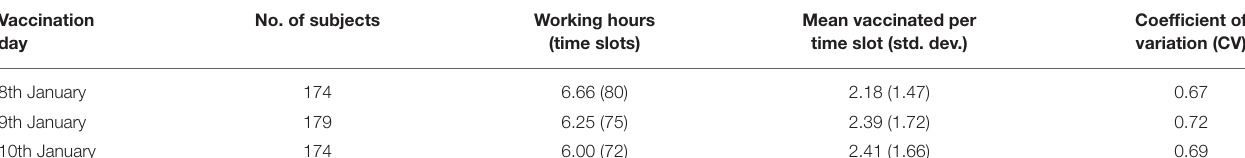
TABLE 1 | Details of the activity regarding the three sampled vaccination days. Vaccination day